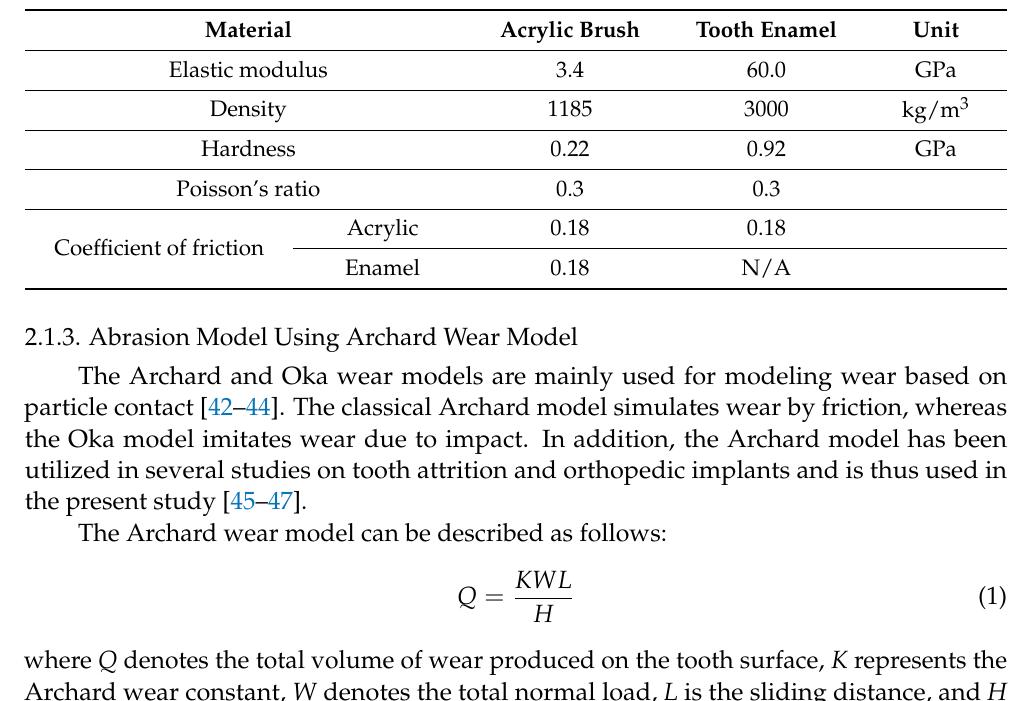
Table 1. Material